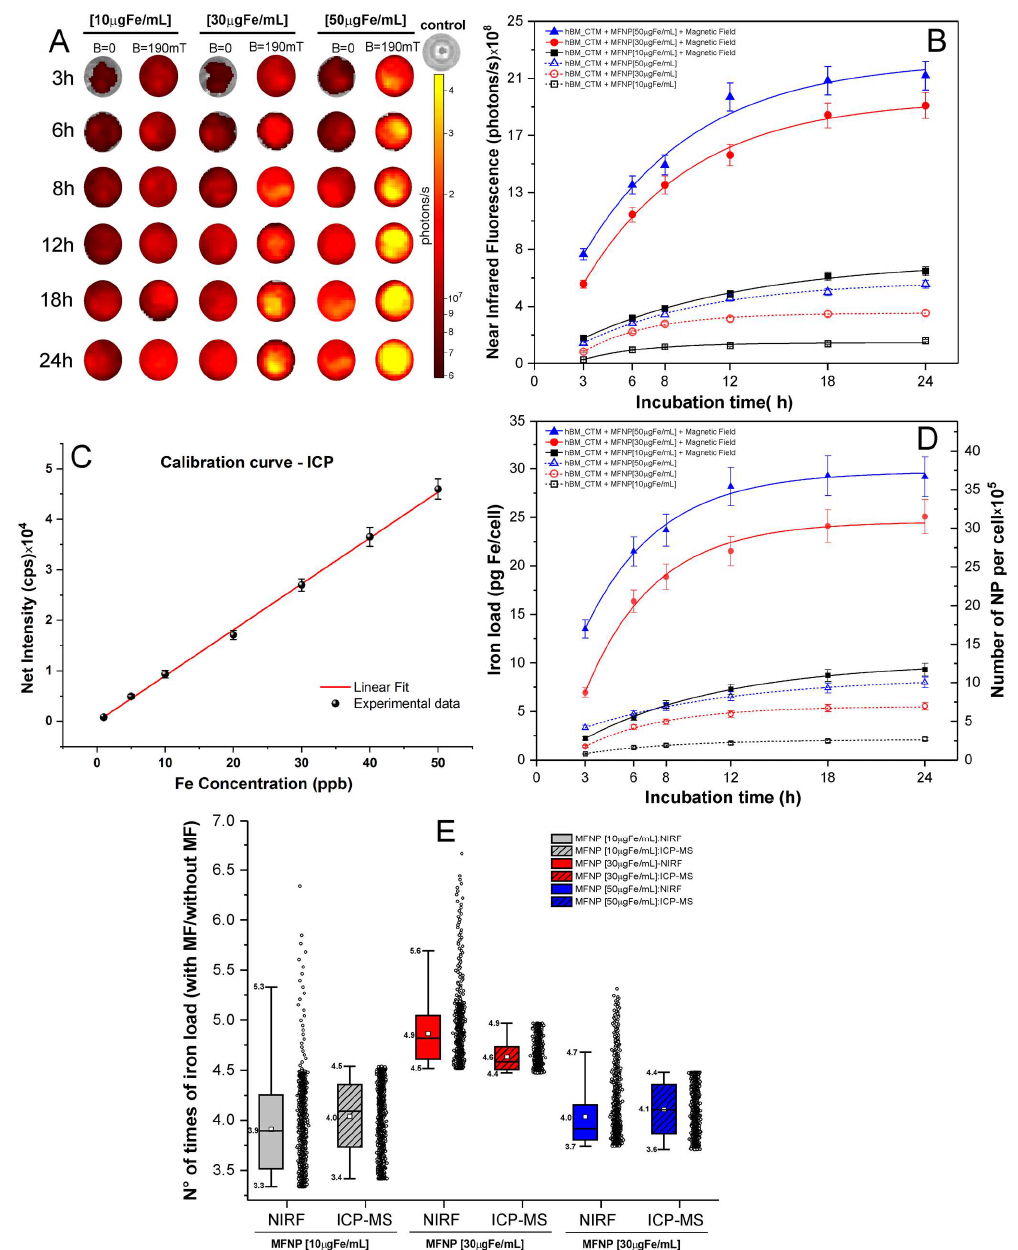
Figure 5. The iron load of MFNP into hBM-MSC quantification by NIRF and ICP, in all labeling conditions tested. ( A ) The NIRF signal intensity analyses over time in different MFNP concentrations and with or without magnetic field (190 mT). ( B ) The iron quantification of NIRF curves in all conditions analyzed, adjusted to lognormal. ( C ) The calibration curve for the ICP quantification; ( D ) The ICP curves of iron quantification of MFNP in all conditions analyzed, and ( E ) the box plot of the NIRF and ICP-MS measure in each condition analyzed with the data represents by the circles.